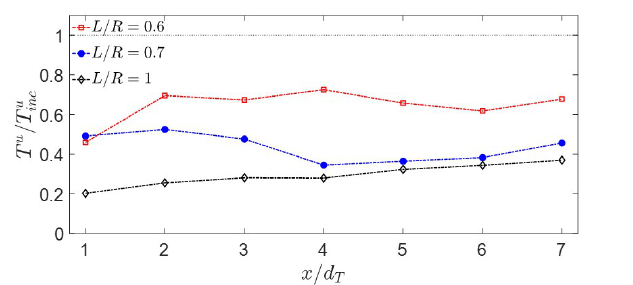
Figure 11. Integral time scale T u distribution normalized by that of the incoming flow T u rotor axis for various L / R .